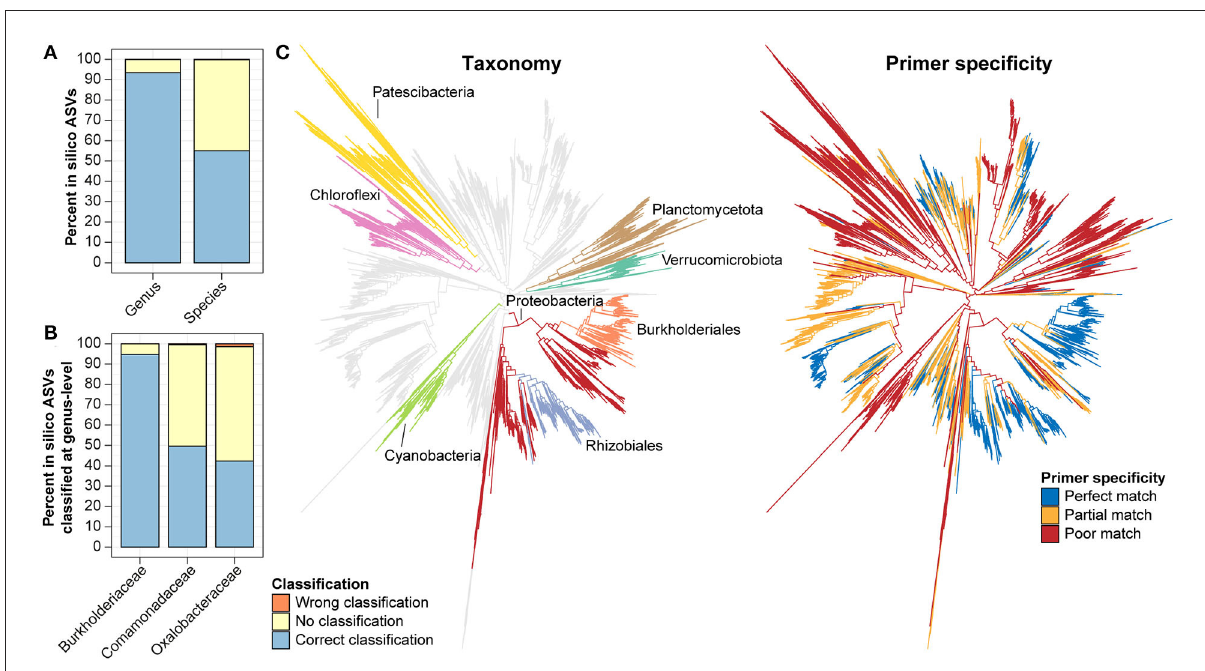
FIGURE5 In silico evaluation of taxonomic resolution and primer mismatch of the V5–V7 primer. (A,B) In silico ASVs corresponding to the region amplified with the V5–V7 primer pair were extracted from all bacterial FL-ASVs (A) or selected families (B) in AsCoM and classified using the AsCoM database. Classifications were evaluated as correctly classified, wrongly classified, or not classified using the taxonomy of FL-ASV in the AsCoM database as the ground truth. (C) In silico , ecosystem-specific evaluation of primer specificity of the V5–V7 primer pair using Primer Prospector and bacterial FL-ASVs from the AsCoM database. The gray branches show perfect hits, the yellow branches show partial hits, and the red branches show poor hits (see Materials and Methods for definitions). The phyla most influenced by primer bias as well as the orders Burkholderiales and Rhizobiales are highlighted in different colors in the taxonomy tree.